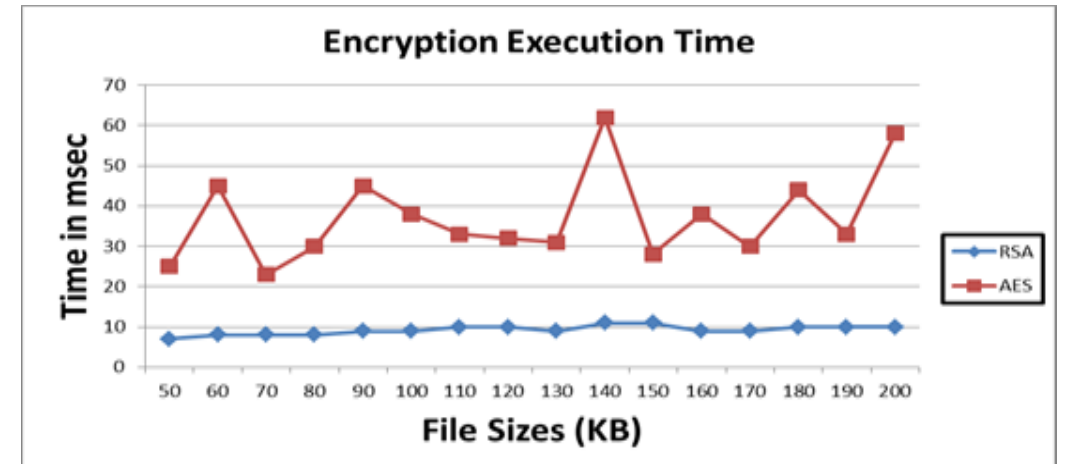
Figure 10 . Encryption Execution Time